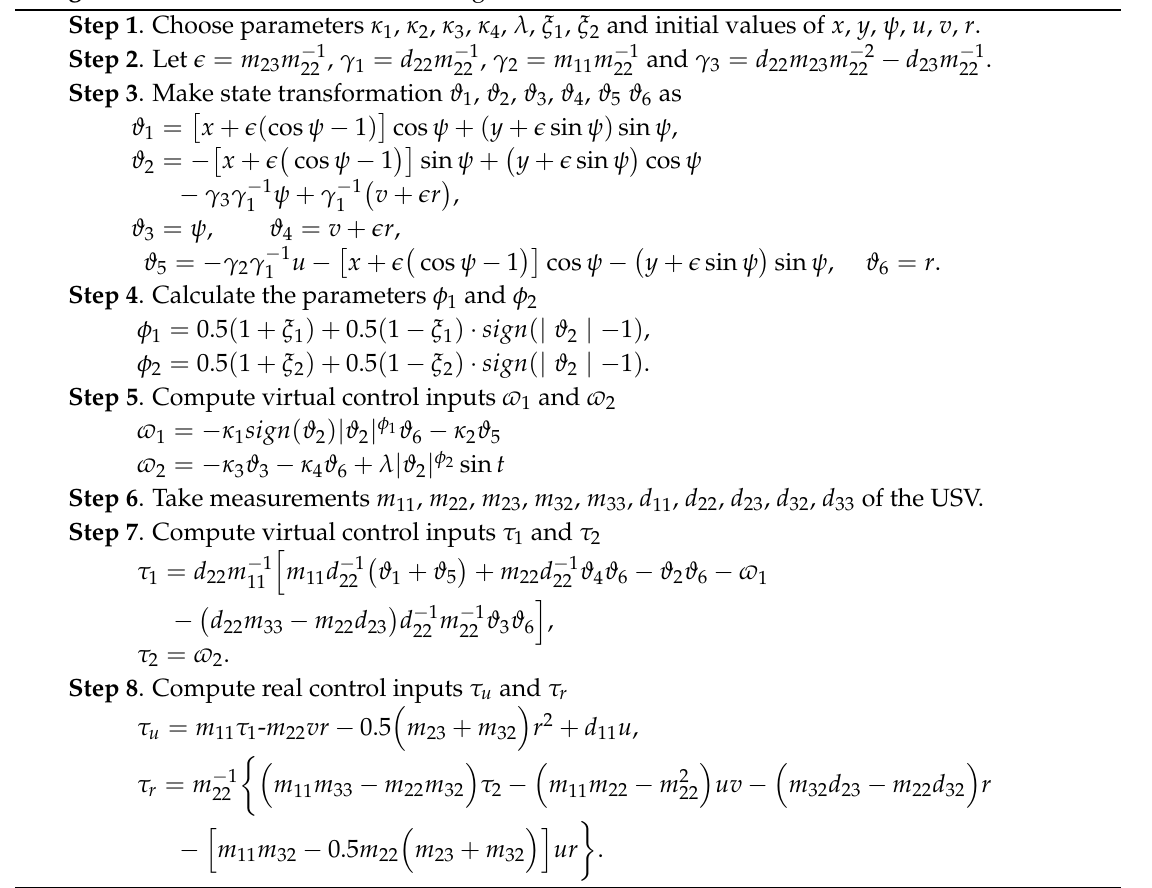
Algorithm 1: The continuous control algorithm of